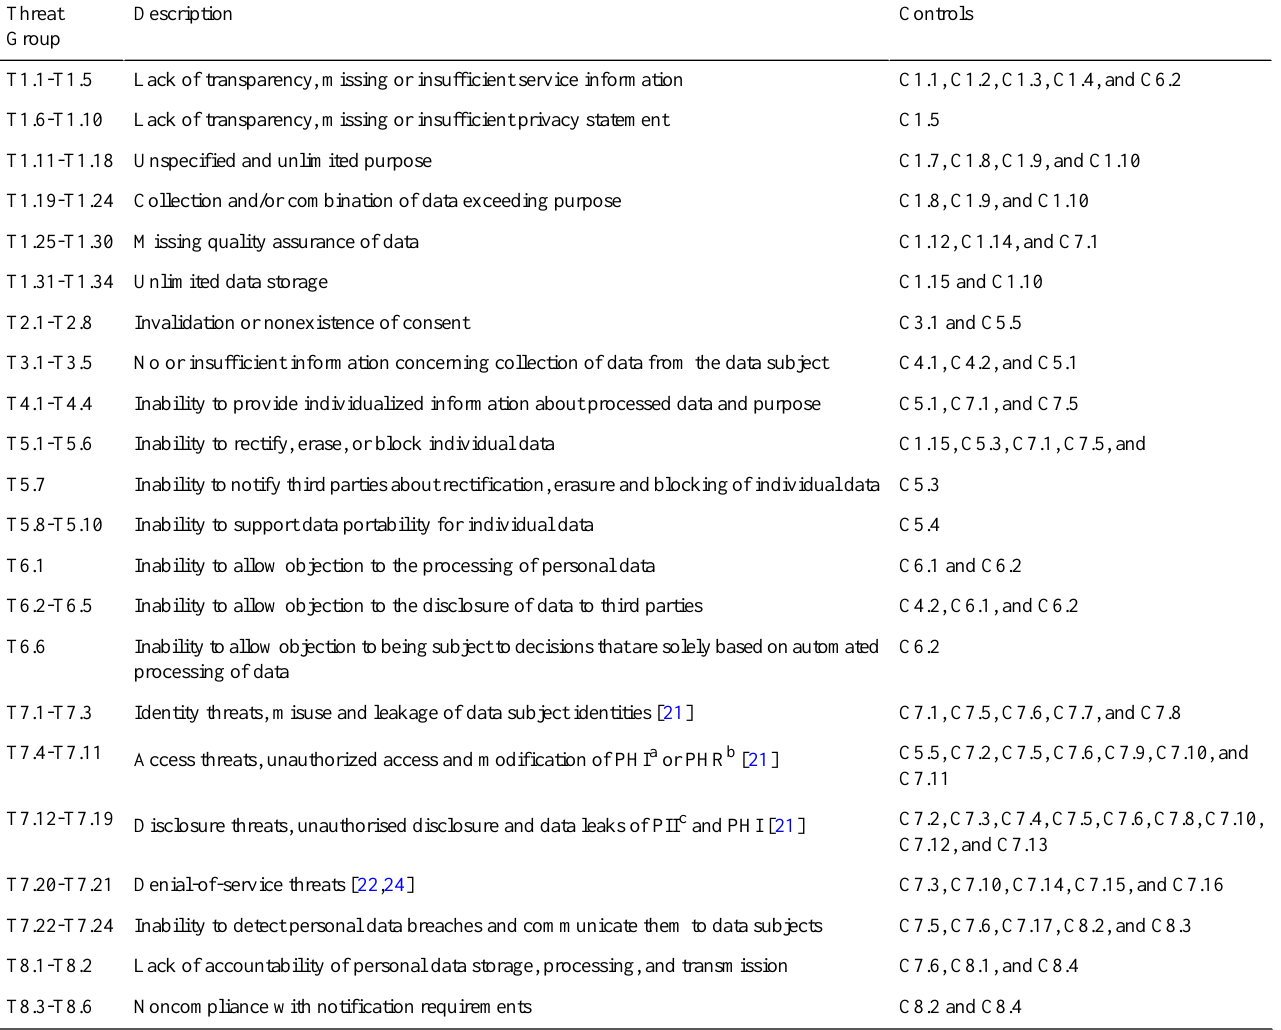
Table 2. Threat groups and associated controls. The detailed description of all subthreats can be found in Multimedia Appendix